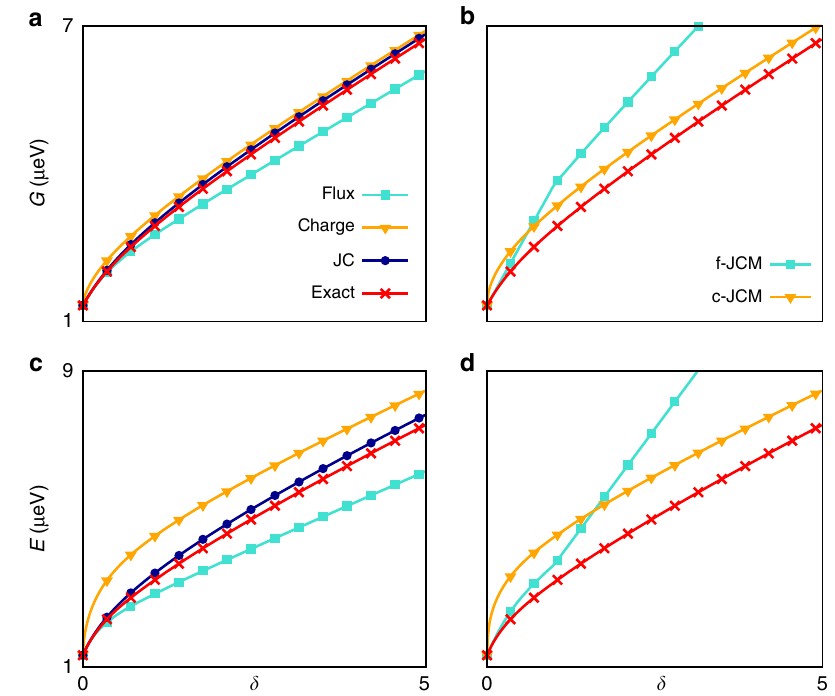
Fig. 2 Lowest energy levels as functions of detuning. a E l = 0.33 μ eV, E J = 10 E l = E c , ϕ ext = π /2 e and η = 1. The ground energy is plotted with δ for the fl ux- gauge and charge-gauge QRMs, for the JC-gauge two-level model and for the exact model. b Same as ( a ) for the charge and fl ux-gauge JCMs obtained as RWAs of the corresponding QRMs. c Same as ( a ) for the fi rst excited energy. d Same as ( c ) for the charge and fl ux-gauge